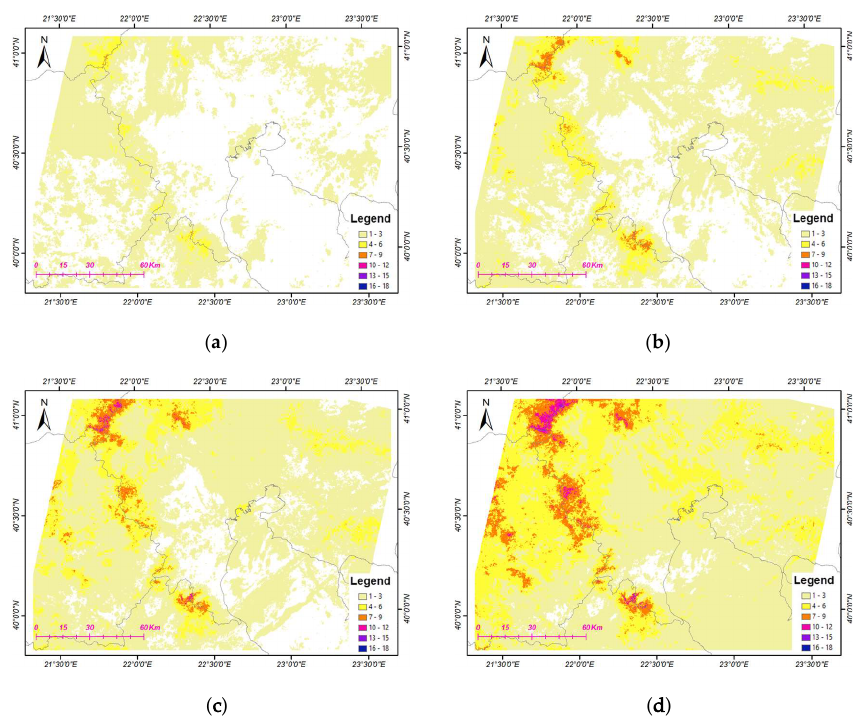
Figure 2. The cloud frequency per pixel i.e., the number of cloudy dates for datasets: ( a ) #1 of total 11 dates, ( b ) #2 of total 14 dates, ( c ) #3 of total 16 dates and ( d ) #4 of total 18 dates. Regions in white represent clear pixels for all